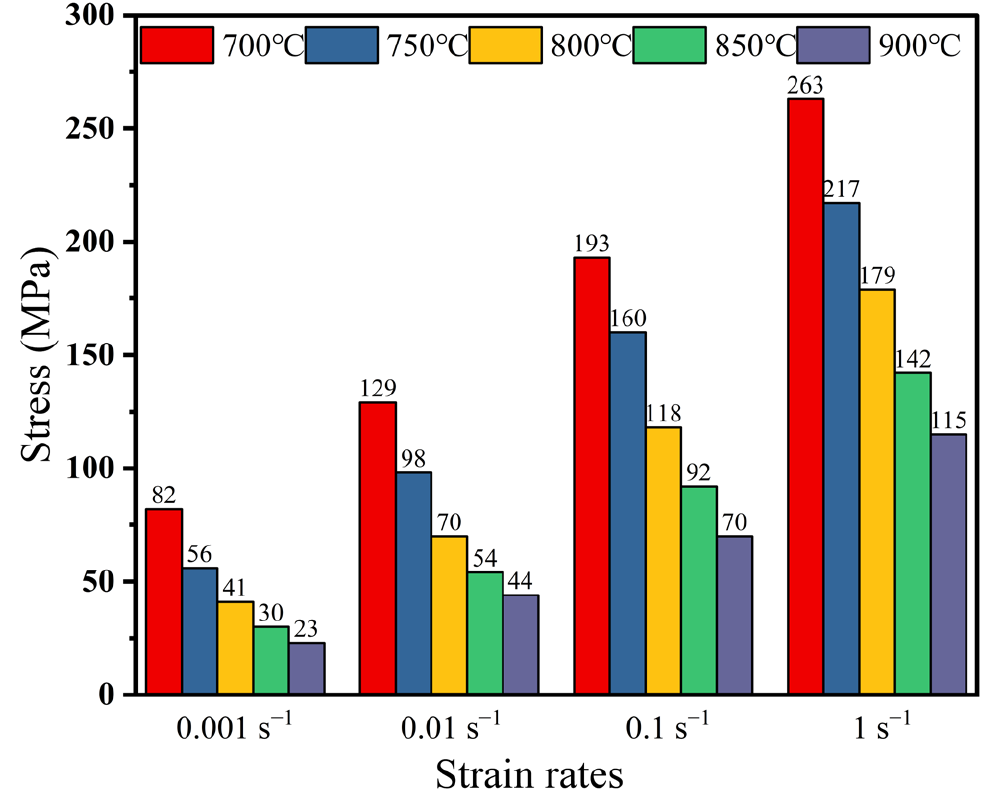
Figure 4. Peak stress of the Cu − 9Ni − 6Sn alloy under different deformation conditions. In the initial stage of deformation, a large number of dislocations appeared in the matrix. The entanglement between the dislocations or the interaction between the dislo- cations and grain boundaries lead to a rapid increase in the strength of the alloy; thus, the flow stress of the alloy increased sharply. After reaching the peak of flow stress, the de- formation of the alloy was completed in a short time at the high strain rate. Therefore, the dislocation density and flow stress values in the matrix were also quite high. At the low strain rate, the alloy underwent significant reduction and recrystallization because the hot deformation temperature was higher than the recrystallization temperature [35]. 3.2. Flow Stress Constitutive Equation The Arrhenius kinetic equation, which is summarized by Sellars et al., describes the thermal processing properties of a material through the characteristic parameters in the true stress–strain curve. The relationship between these characteristic parameters, such as